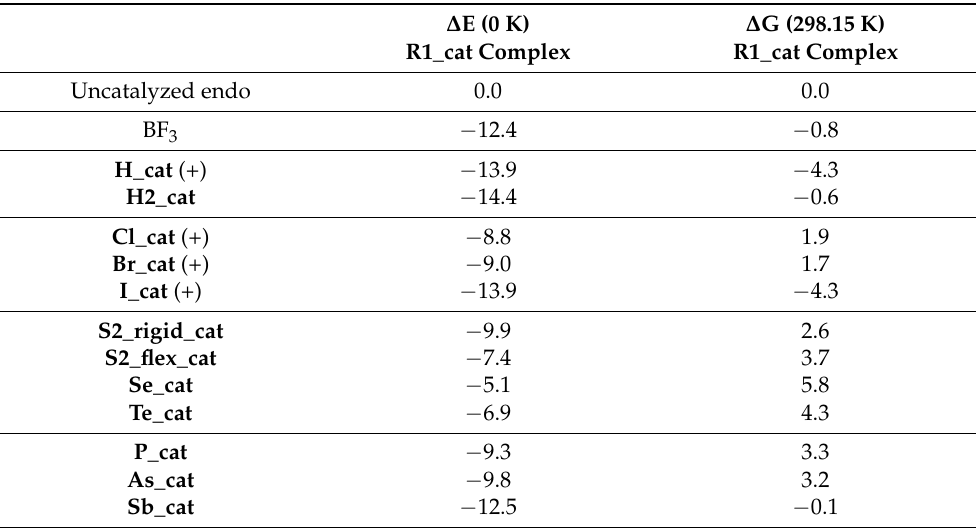
Table 1. ∆ E (0 K) and ∆ G (298.15 K) values for the reactant complex formation between benzaldehyde (R1) and the catalyst (cat), in kcal mol − 1 . The + sign in between parentheses indicates a positively charged